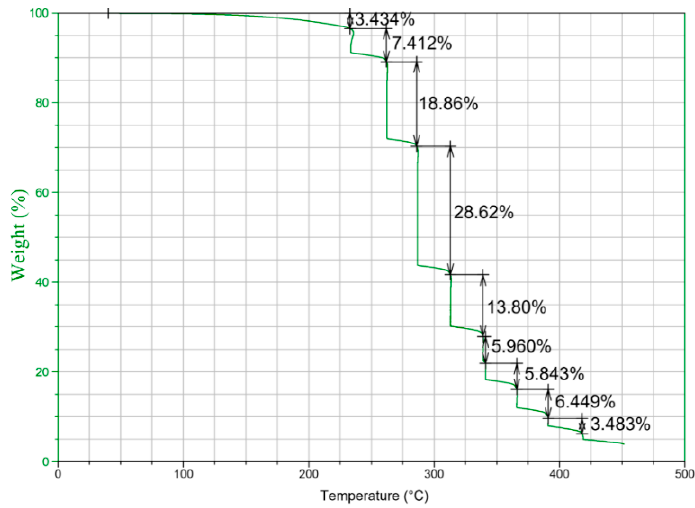
Figure 7. Thermo-gravimetric analysis (TGA) chart of 4 hr heat-treated guayule resin (B(4)), stepwise isothermal thermo-gravimetric (SITG) method—from ambient temperature to 450 °C.